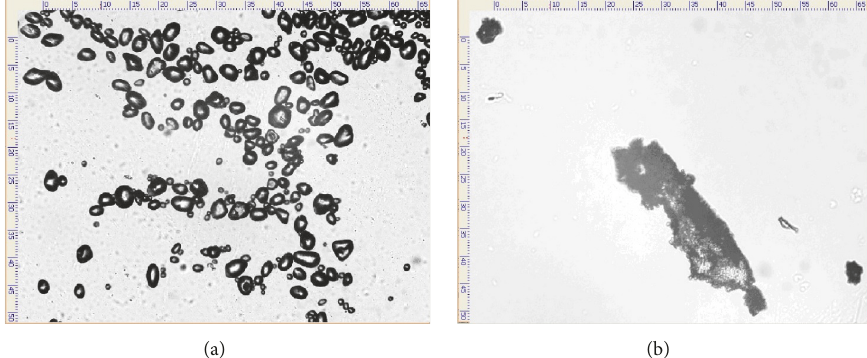
Figure 5: Appearance of grains of native (a) potato and modified (b) starches magnified ×